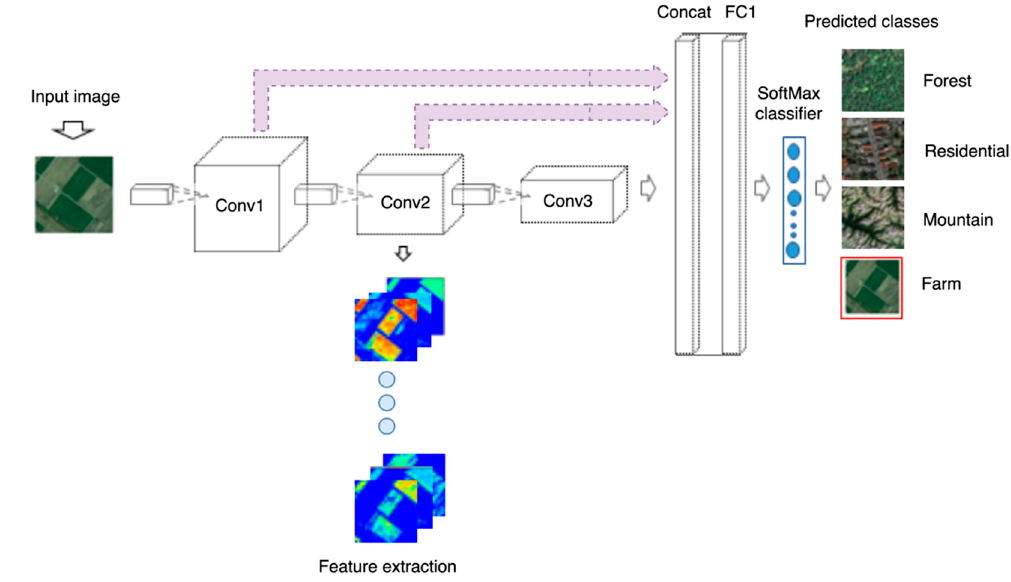
Figure 2. Architecture of our proposed texture-based (Tex-) CNN model. Con1, Conv2, and Conv3 denote convolutional layers, while FC1 denotes fully connected layer. Concat layer represents concatenation of Conv1, Conv2, and Conv3 feature maps.